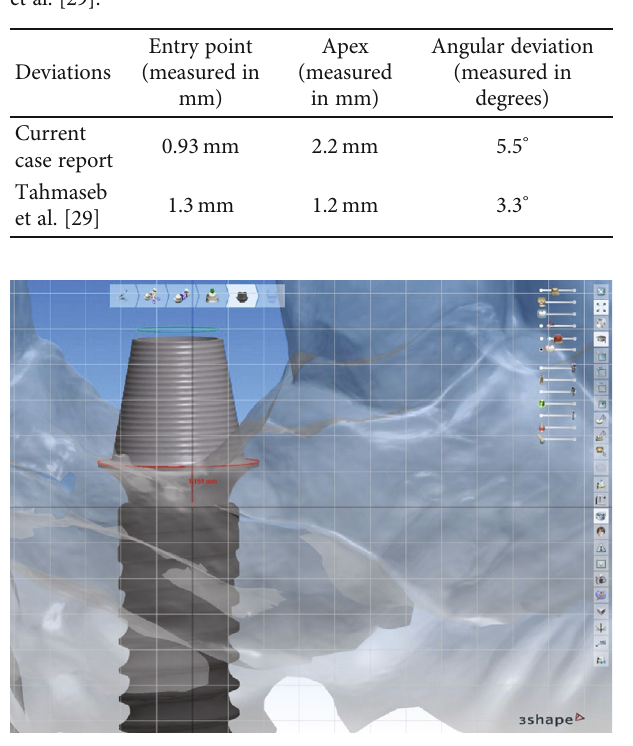
Table 1: Comparison between the deviations presented in the current case report and the mean deviations in partially edentulous patients reported in a systematic review by Tahmaseb et al.